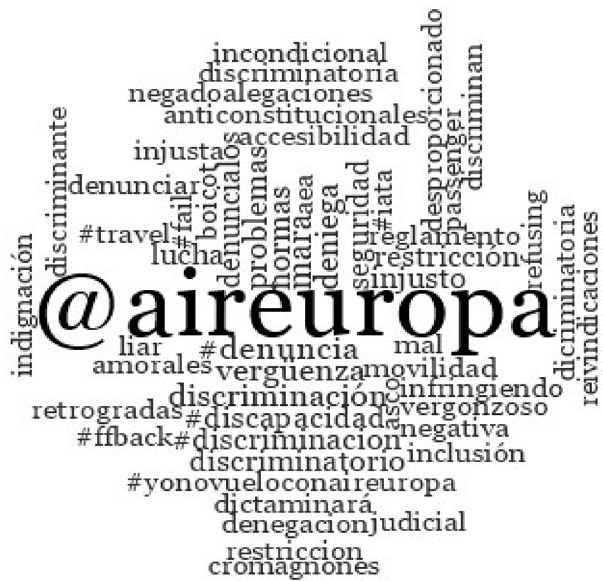
Figure 1. Word cloud